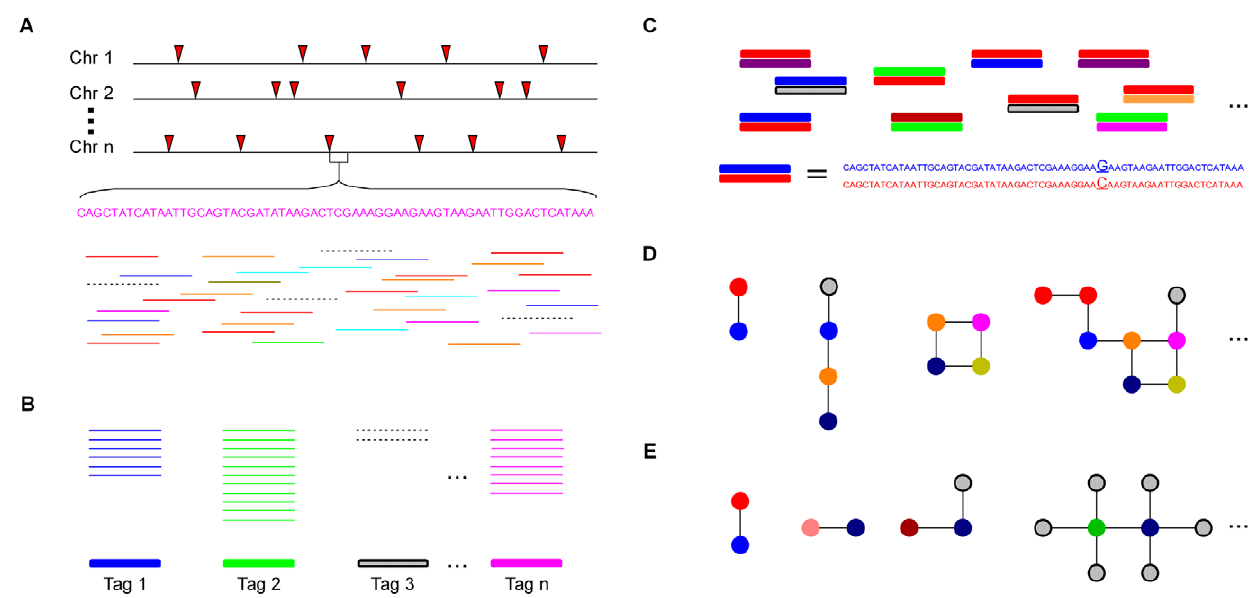
Figure 1. The analytical framework of UNEAK. (A) Multiple DNA samples are digested and sequenced using GBS (red arrows represent cut sites). The inputs of UNEAK are Illumina Qseq or Fastq files. All of the reads are computationally trimmed to 64 bp. The solid colored lines represent error-free (‘‘real’’) reads, while the dashed lines are reads containing one or more sequencing errors. (B) Identical reads are classified as a tag. The colored bars are real tags, whereas the shaded bar is a rarer error tag. (C) Pairwise alignment is performed to find tag pairs differing by only a single bp mismatch. (D) Topology of tag networks. The colored circles are real tags. The shaded circles are error tags. Lines (‘‘edges’’) are drawn only between tags that differ by a single bp mismatch. (E) Only reciprocal, real tag pairs are retained as SNPs.